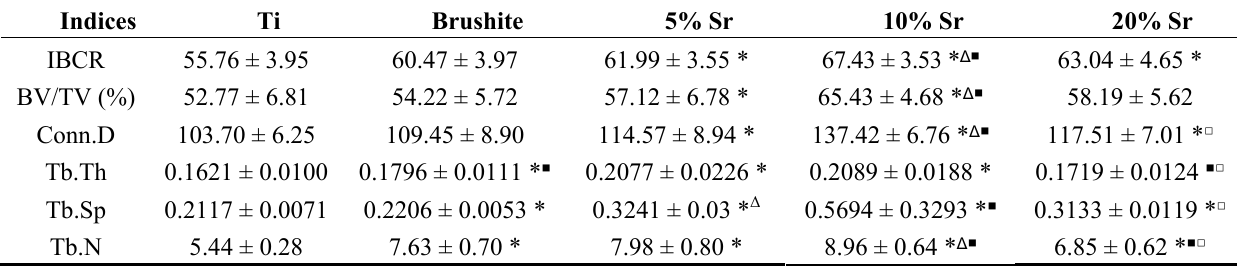
Table 1. Micro-CT analysis of bone indices among five groups ( n =